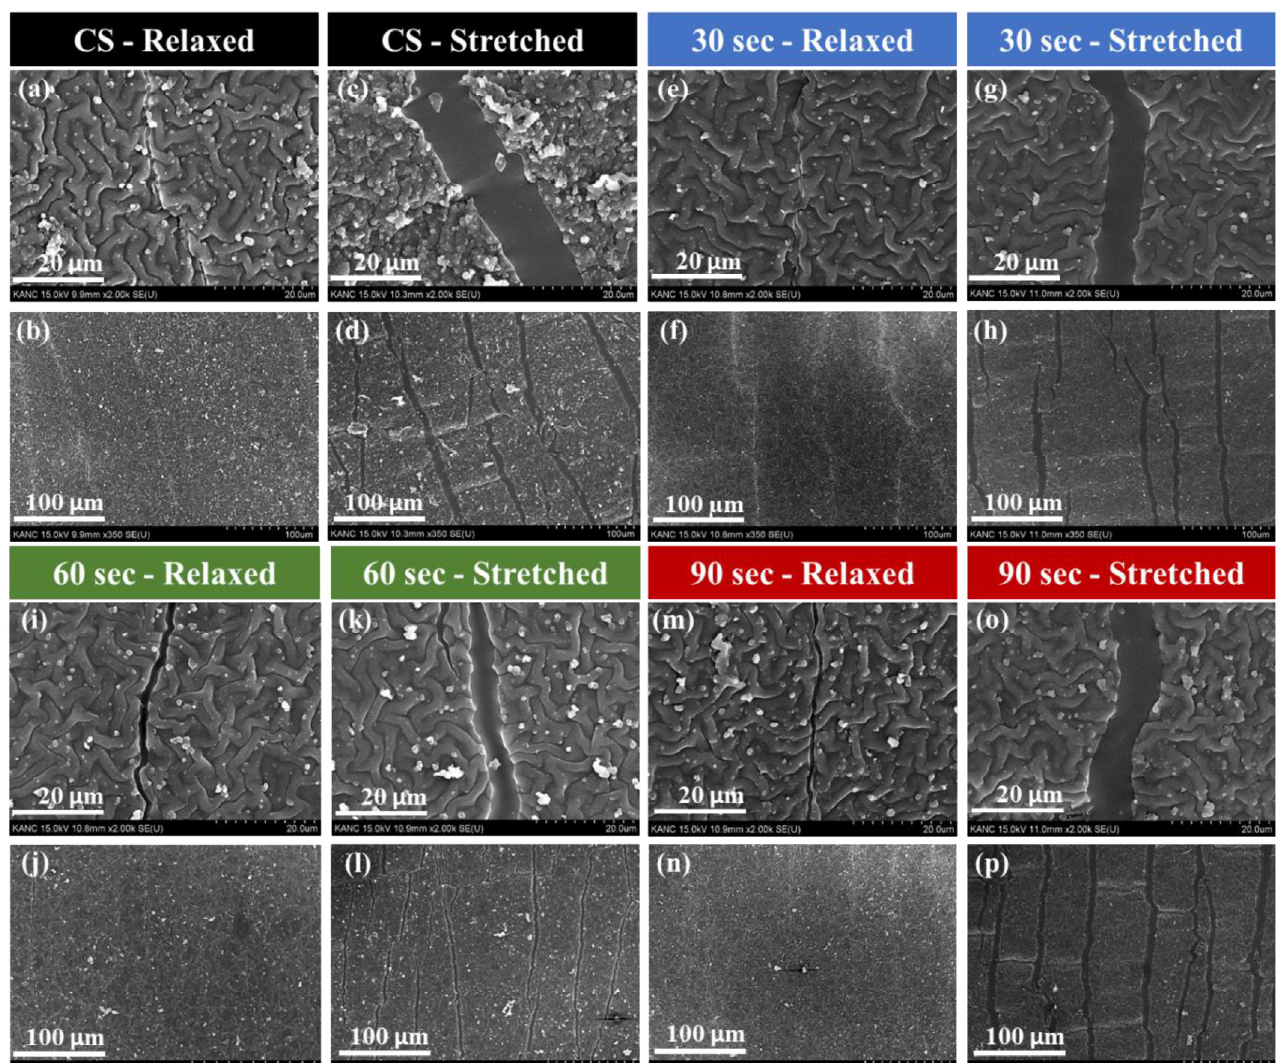
Figure 2. SEM top-views of the PPy films on PDMS substrates synthesized under different PT con- ditions of ( a – d ) CS (no O 2 PT), ( e – h ) 30 s O 2 PT, ( i – l ) 60 s O 2 PT, and ( m – p ) 90 s O 2 PT. A total of 500 cyclic loads of strain (20%)/relaxation were applied in advance to the PPy films before SEM obser- vation. Images shown on the left columns of each PT condition were taken under relaxed condition at two different magnifications (top: × 2000, bottom: × 350). Images shown on the right columns were taken under the same uniaxial stretching condition (5%) to make the surface microcracks more visible. Microcrack densities of the PPy films after being stressed by 500 cyclic uniaxial stretch- ing (20%) and release were measured to quantitatively examine the effect of O 2 PT.